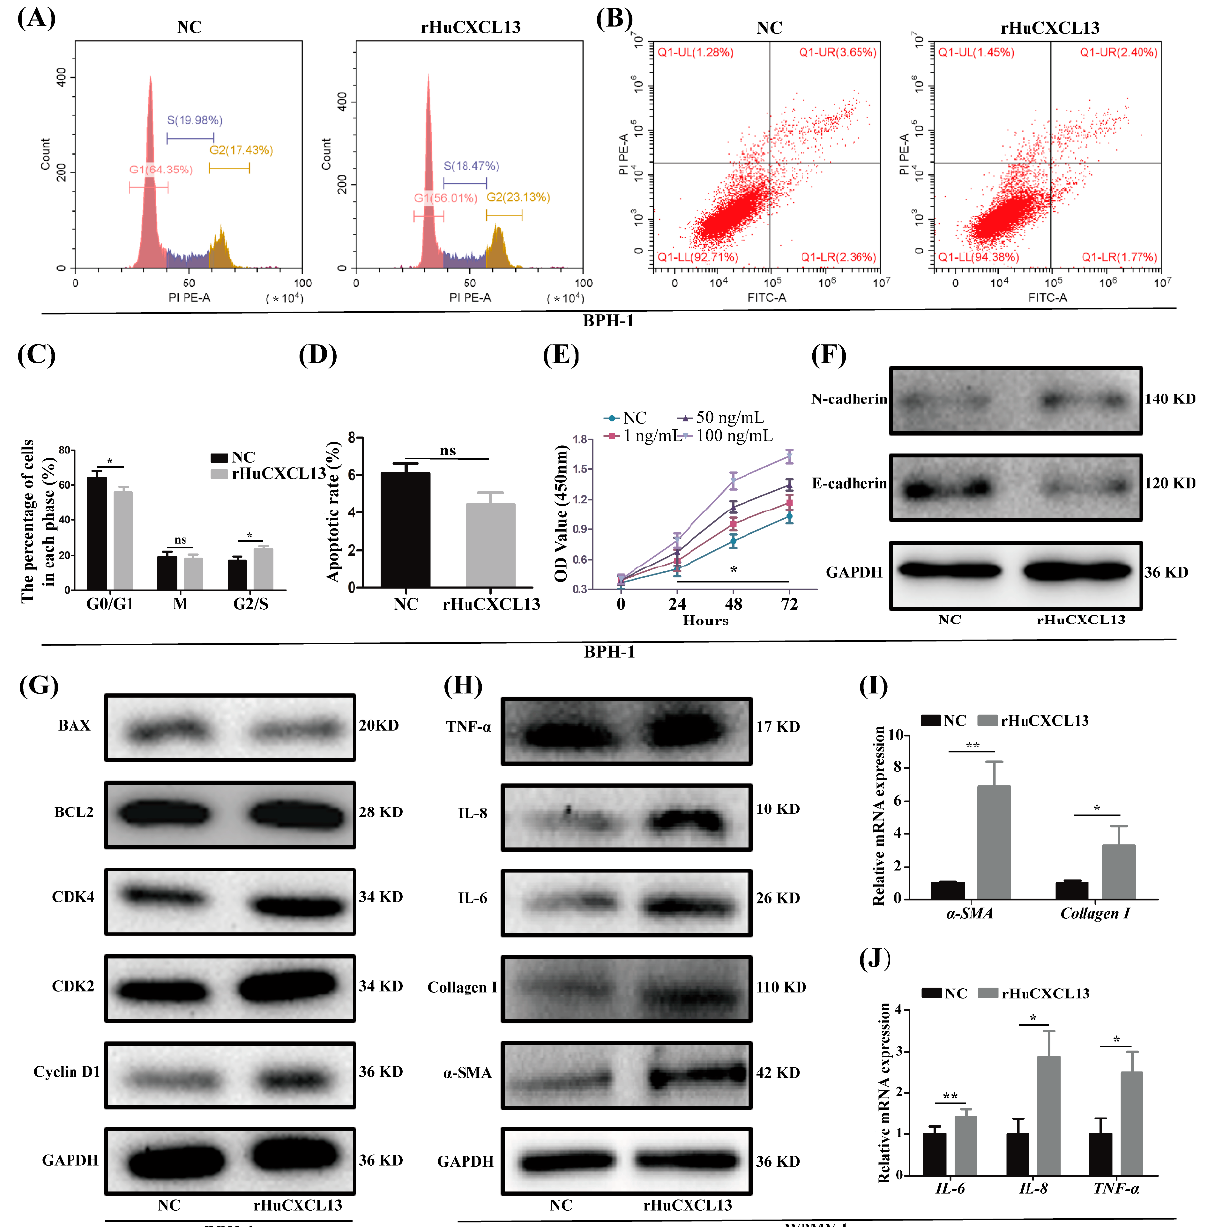
Figure 2. rHuCXCL13 treatment promoted proliferation of BPH-1 cells, fibrosis and inflammation of WPMY-1 cells. ( A , B ) Flow cytometry analysis of cell cycle and cell apoptosis in BPH-1 cells. ( C , D ) Statistical analysis of percentages (%) of cells at each stage and apoptotic rate (%) in BPH-1 cells. ( E ) CCK8 assay of BPH-1 cells. ( F , G ) Western blot assay of EMT-, cell-cycle- and apoptosis-related proteins in BPH-1 cells. ( H – J ) The mRNA and protein expression of markers of fibrosis and inflammation in WPMY-1 cells. * p < 0.05, ** p < 0.01 and ns means no significant difference.